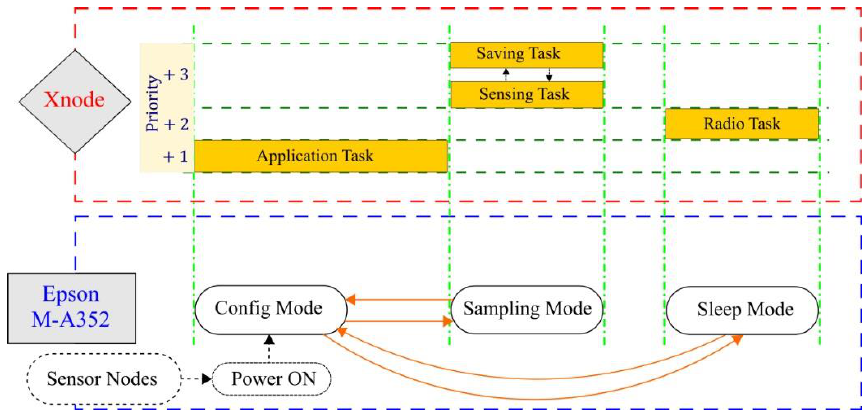
Figure 2. Xnode task handlers and corresponding mode of operation in M-A352 .